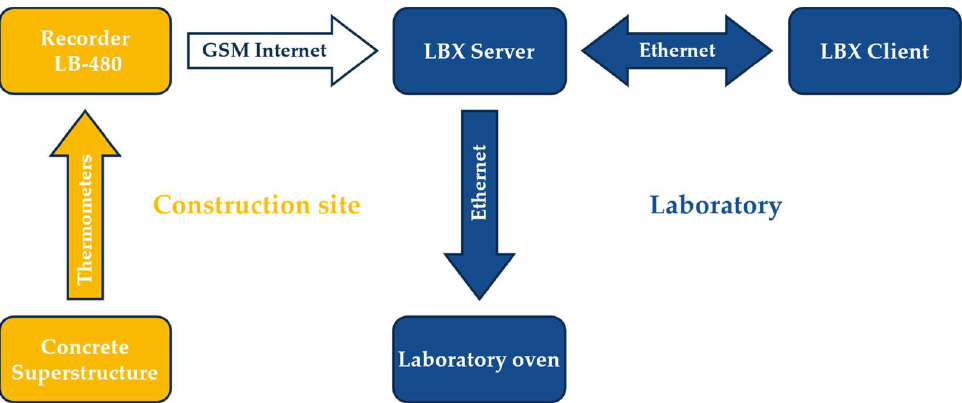
Figure 4. System of structure conditions of concrete curing.